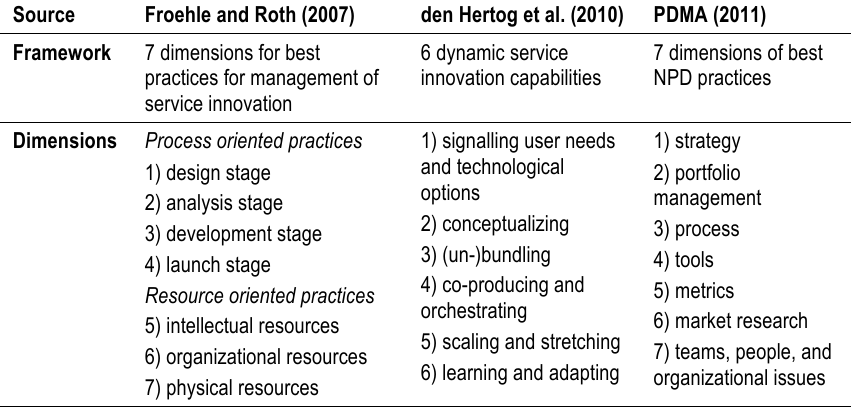
Table 1. The frameworks for new products and service development practices Source Froehle and Roth